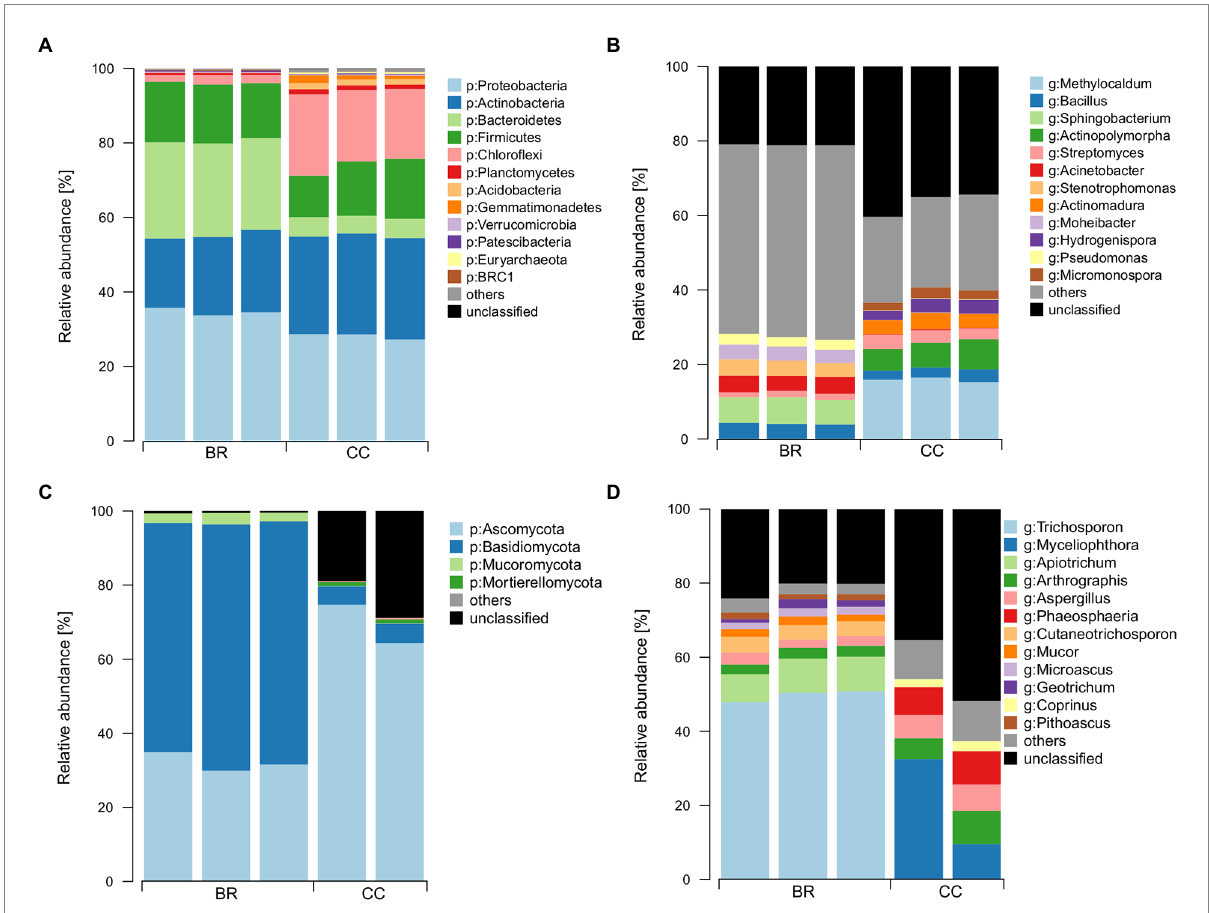
FIGURE 2 Most abundant bacterial and fungal phyla ( A and C , respectively) and genera ( B and D , respectively) in the two organic fertilizers. BR: BSFL residue, CC: conventional compost.